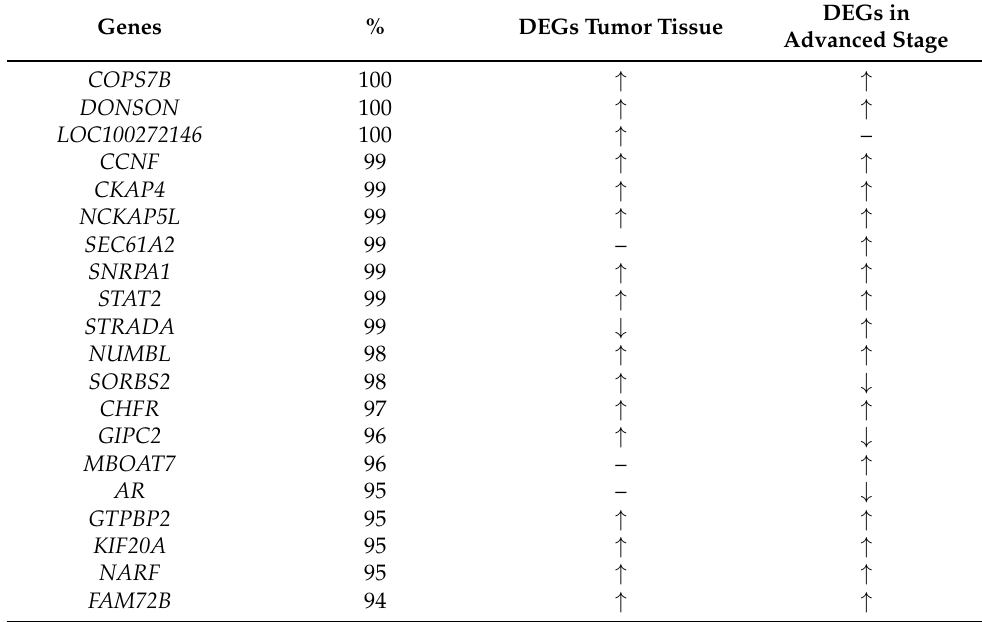
Table 5. List of the top 20 genes selected by elastic net in at least 50% of the runs when α = 0.2. Arrows represent if genes are upregulated ( ↑ ) or downregulated ( ↓ ) in tumor tissue or in the advanced stage of the disease and % is the percentage of the runs where a certain gene appears in the solution. – genes that are not differentially expressed in tumor tissue.